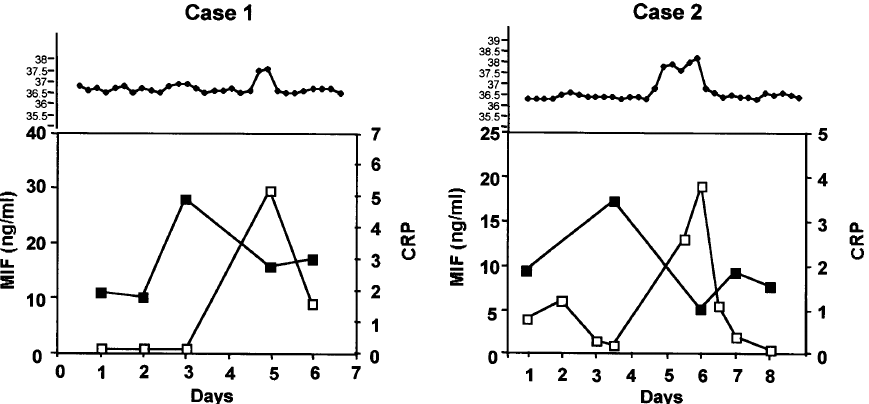
FIG. 1. Changes in body temperature, serum MIF, and CRP in patients with acute tonsillitis. The patients with acute tonsillitis (case 1, a 6-year-old male; and case 2, a 9-year-old male) were admitted to Hokkaido University hospital. Body temperature, CRP ( I ), and serum MIF ( j ) were examined during the course of